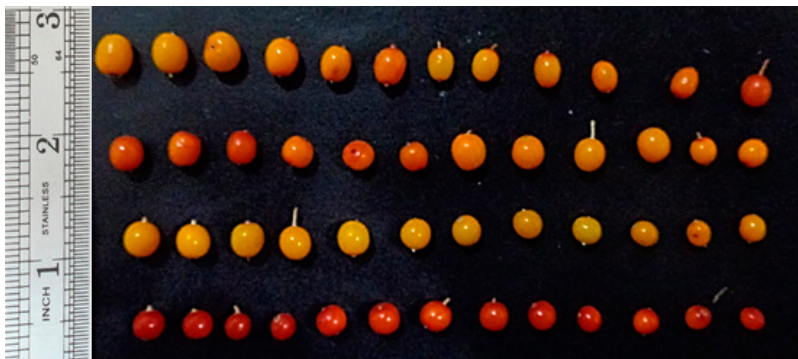
Figure 2. A sample of fruits from different sea buckthorn individuals collected in the Gilgit and Baltistan regions, northern Pakistan in 2016 representing diversity in size, shape and color.